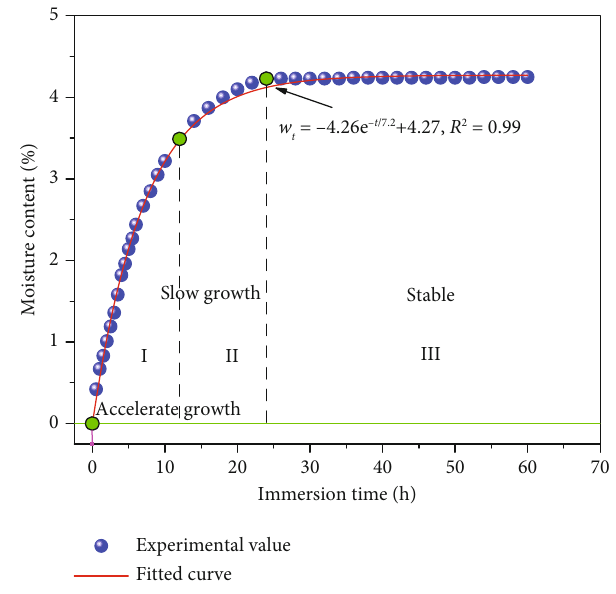
Figure 5: Variation of moisture content with immersion